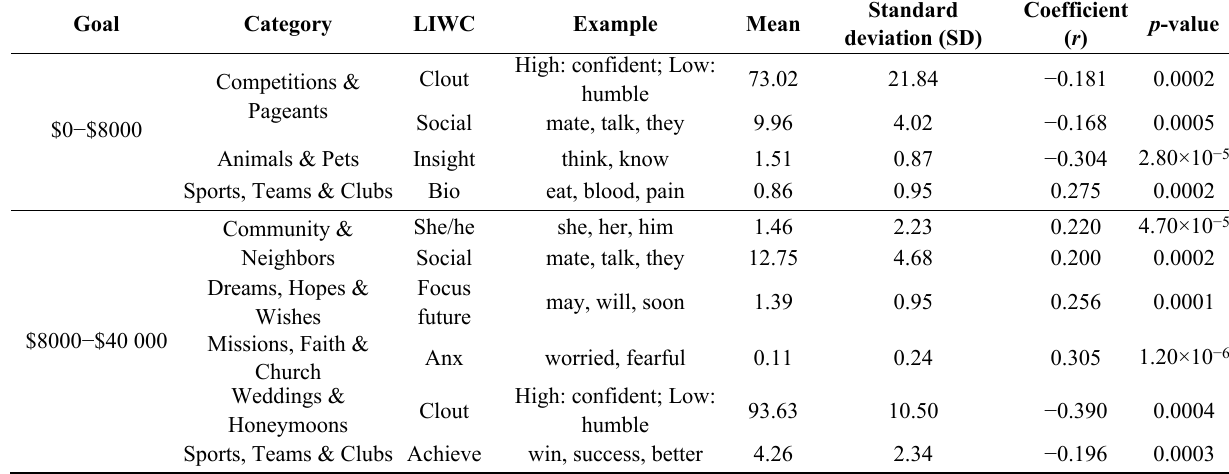
Table 2 LIWC features that have significant